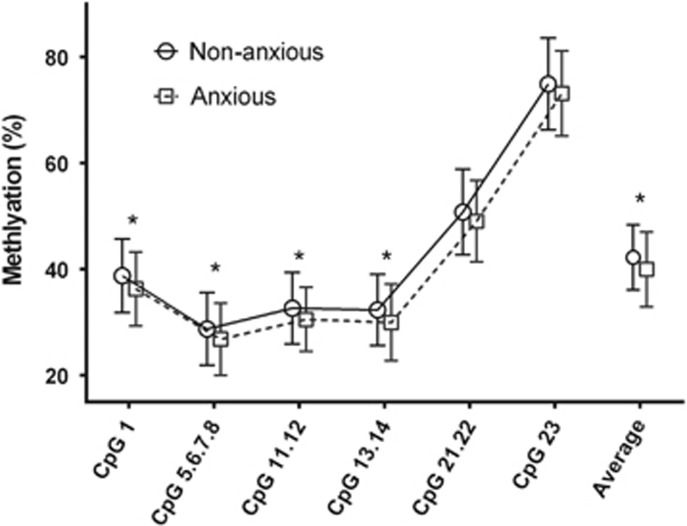
Population distribution of IGF2/H19 ICR DMR methylation levels in infants born to anxious and non-anxious mothers. *P⩽0.016. Error bars are standard deviation. DMR, differentially methylated region; ICR, imprinting control region.